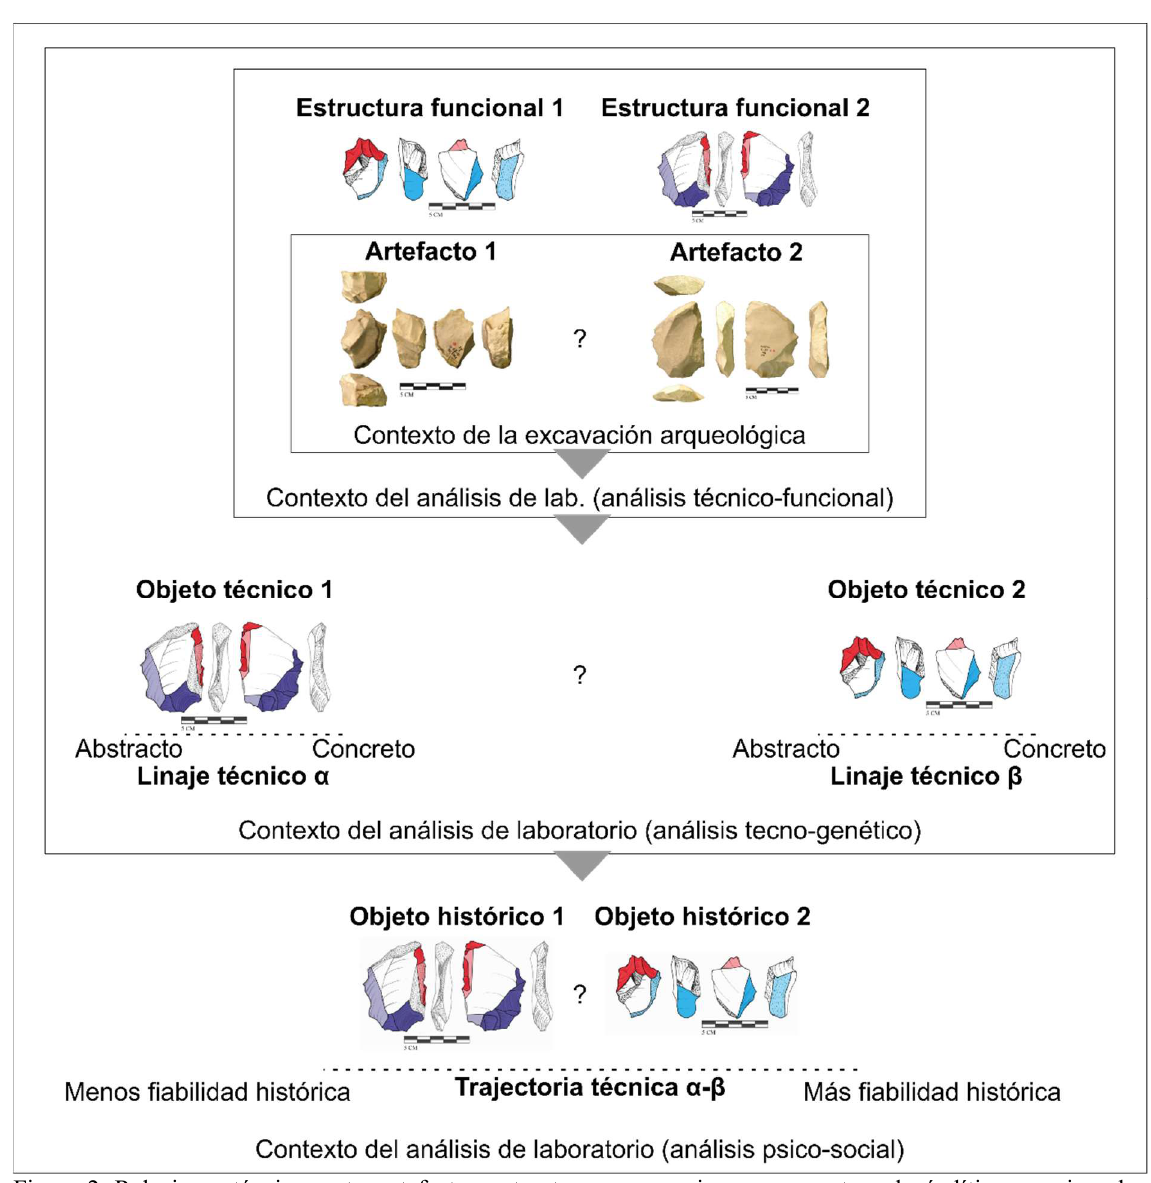
Figura 2. Relaciones técnicas entre artefactos, estructuras y operaciones, en una tecnología lítica que sigue los principios de una epistemología de